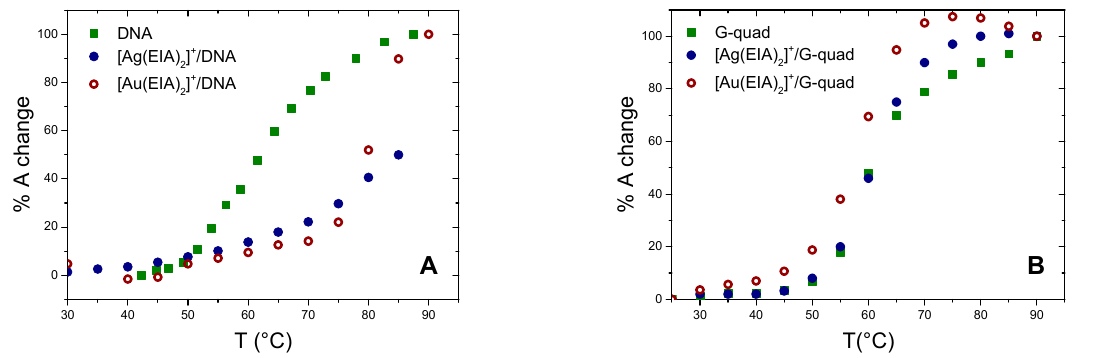
Figure 4. ( A ) Melting plot of DNA alone (C DNA = 2.00 × 10 − 5 M) and DNA with [Ag(EIA) 2 ] + or [Au(EIA) 2 ] + , C DNA / C Ag = C DNA / C Au = 1, NaCac 2.5 mM, pH = 7.0. ( B ) Melting plot of G4 only (C G4 = 4.72 × 10 − 7 M) and in the presence of [Ag(EIA) 2 ] + or [Au(EIA) 2 ] + added, C G4 / C Ag = 1.4, C G4 /C Au = 0.5, KCl 50 mM, NaCac 2.5 mM, pH = 6.5.